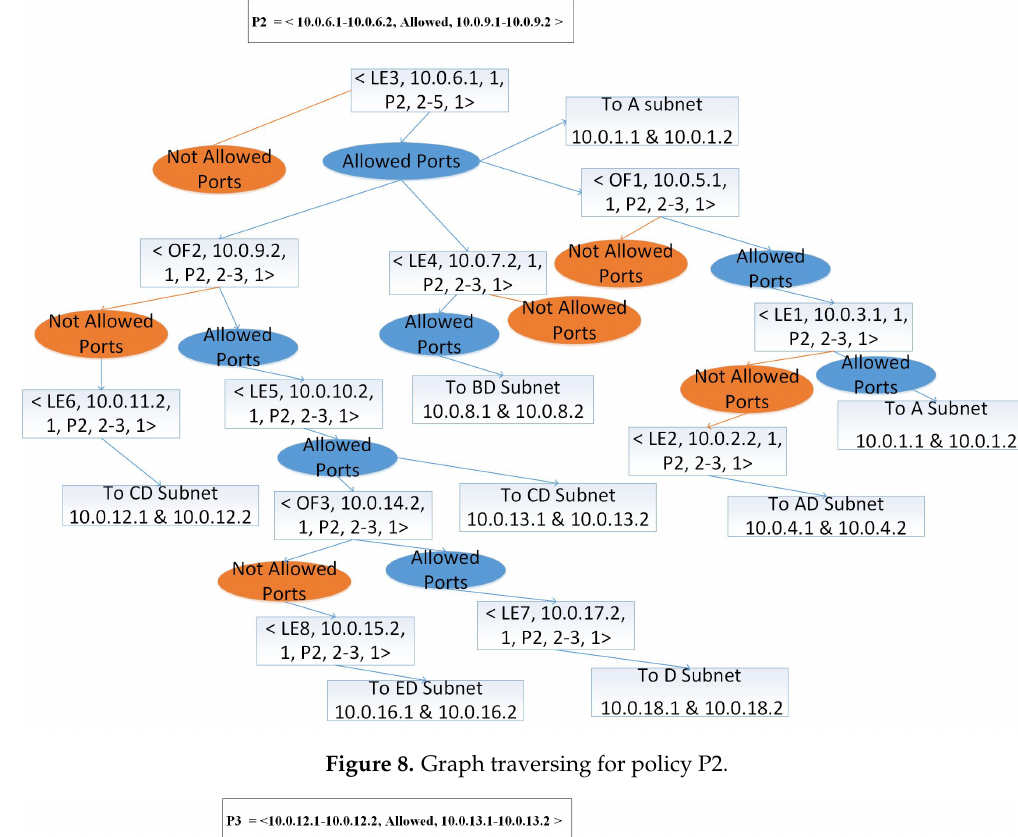
Figure 8. Graph traversing for policy P2.